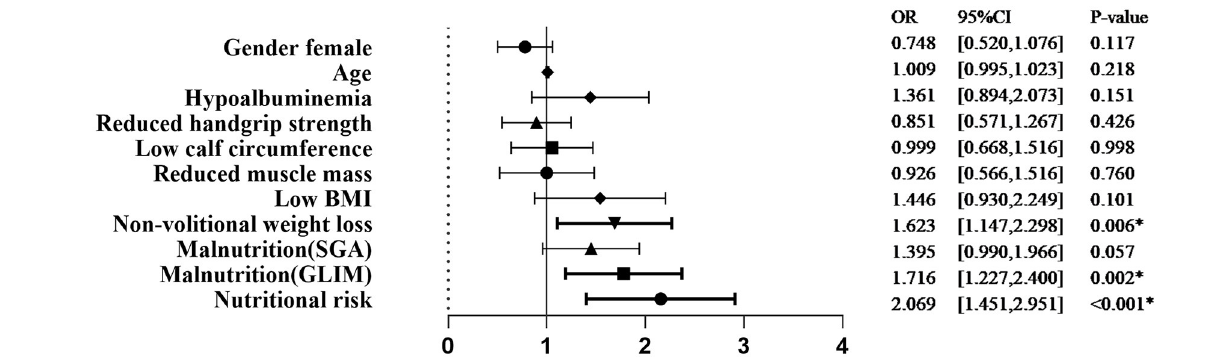
FIGURE 1 | Univariate analysis of demographic characteristics, nutritional status, and GLIM criteria associated with complications. SGA, subjective global assessment; GLIM, Global Leadership Initiative on Malnutrition; BMI, body mass index; OR, odds ratio. * p <